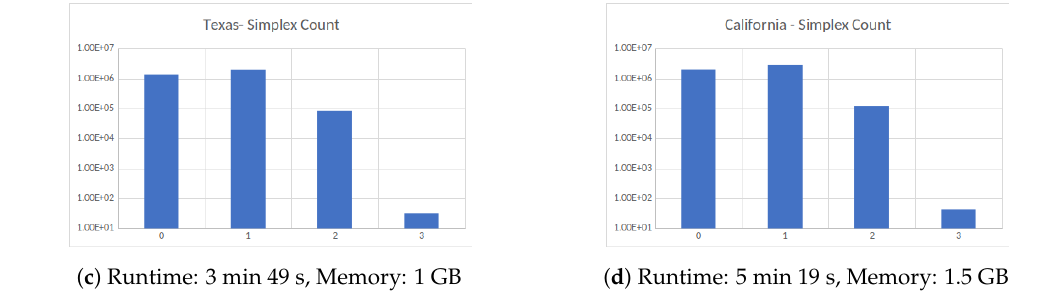
Figure 4. Four large datasets taken from the Koblenz Network Collection [11]. ( a ) Social network of YouTube users and their friendship connections, ( b ) friendship data of Facebook users, ( c ) road network of the State of Texas, a node is an intersection between roads or road endpoint and edges are road segments and ( d ) Road network of the State of California. All computations were carried out on an HPC cluster using 256